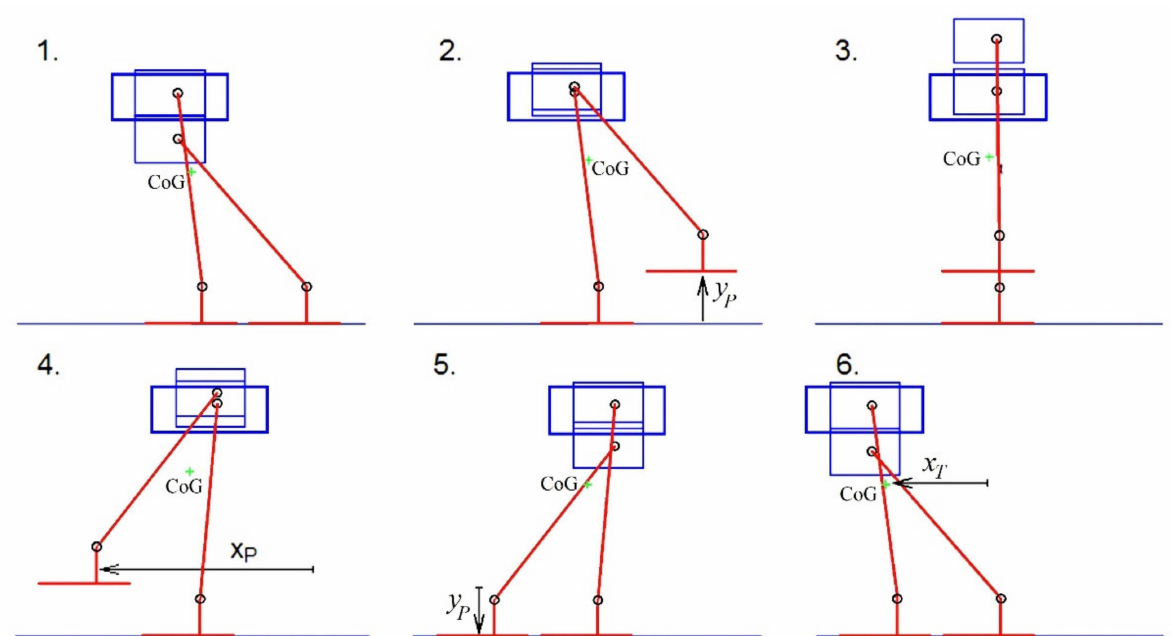
Figure 10. Changes in the position of the foot and center of gravity of the robot during the step. Legends: 1—the center of gravity of the robot is above the right foot; 2—the left linear actuator performs the upward stroke of the left foot; 3—the left ankle joint rotates to move the left foot forward and at the same time the right ankle joint balances the robot’s pose to the vertical position of the legs; the right linear actuator also works to keep the base at a constant height; 4—the left ankle joint transmits the left foot forward and at the same time the left linear actuator lowers the foot; the right linear actuator also lifts the base to keep it at a constant height. 5—the left foot is lowered to the ground; 6—both ankle joints rotate so that the center of gravity is transferred above the left foot and at the same time the height position of the base is compensated by the movement of both linear